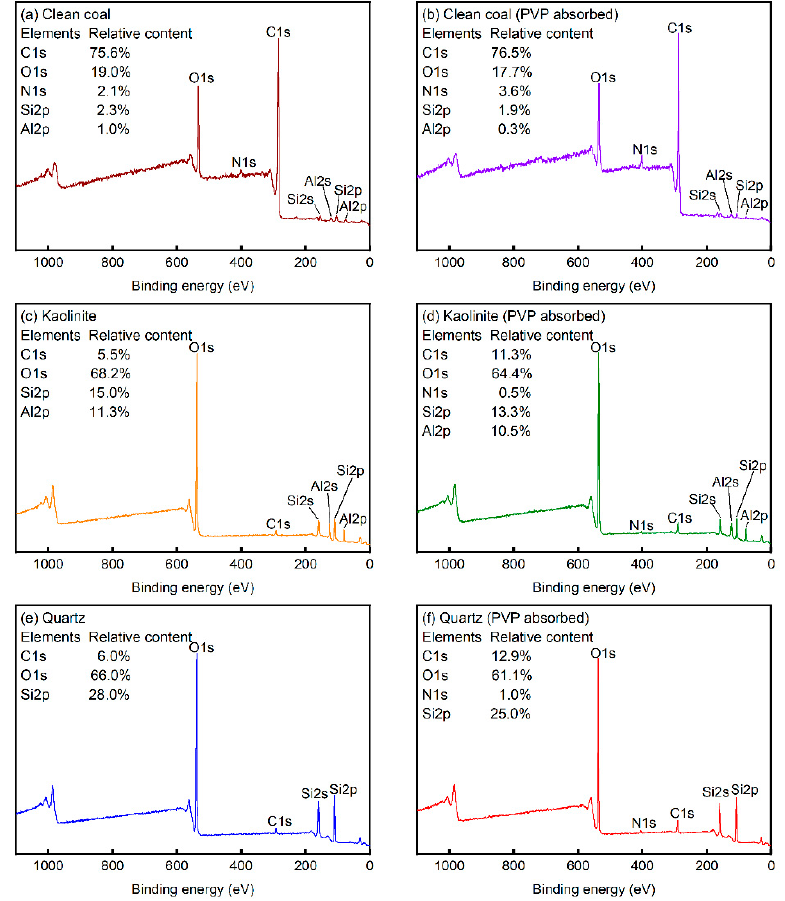
Figure 10. Changes in the wide energy spectrums of clean coal, kaolinite, and quartz tested by XPS: ( a ) clean coal, ( b ) clean coal with PVP treatment; ( c ) kaolinite, ( d ) kaolinite with PVP treatment; ( e ) quartz, ( f ) quartz with PVP treatment.